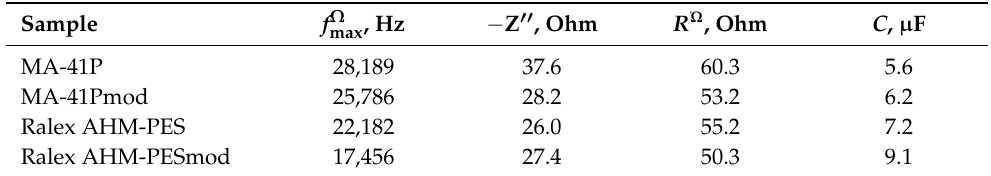
Table 3. Determination of the effective capacitance of the electric double layer, C , and the Ohmic resistance of membranes,